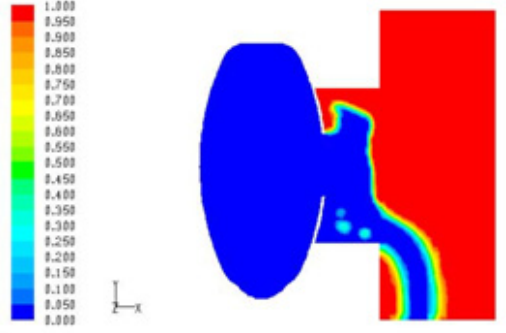
Fig. 2-5. Phase interface, low pressure difference, 0.7 s after start (model